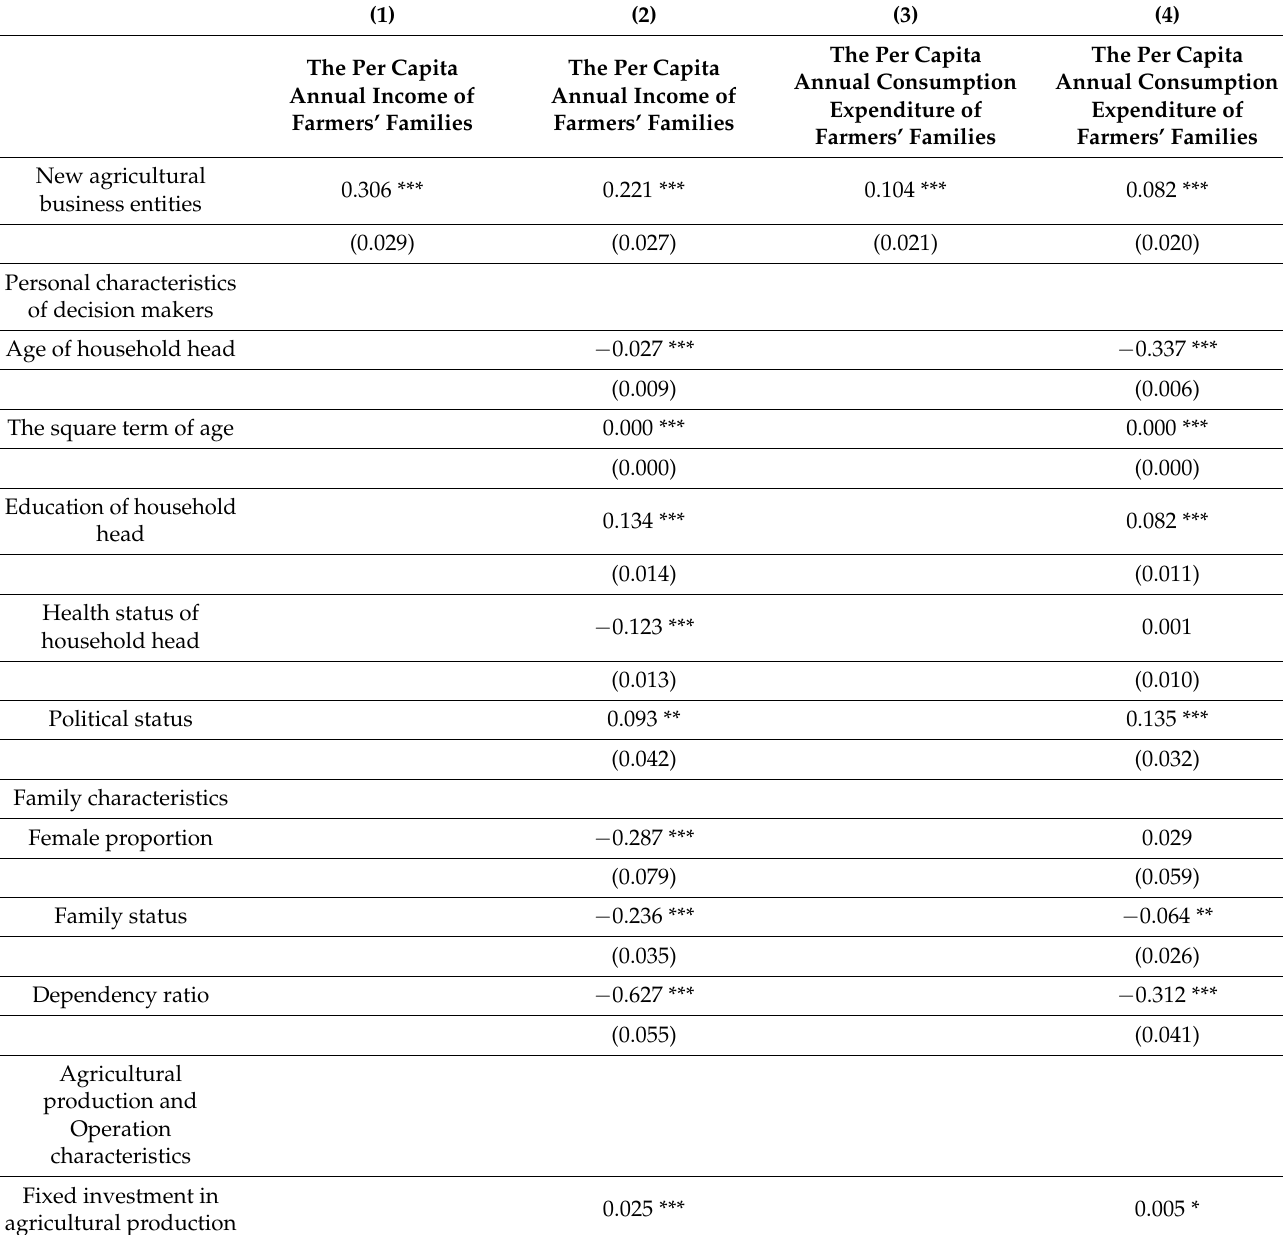
Table 3. The influence of new agricultural business entities on the economic welfare of farmers’